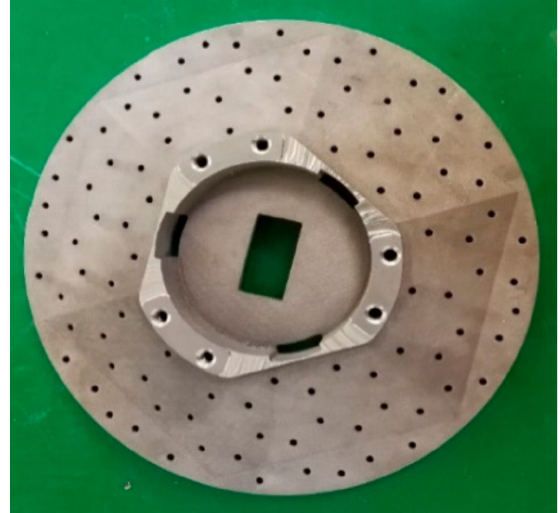
Figure 10. The mounting benchmark after